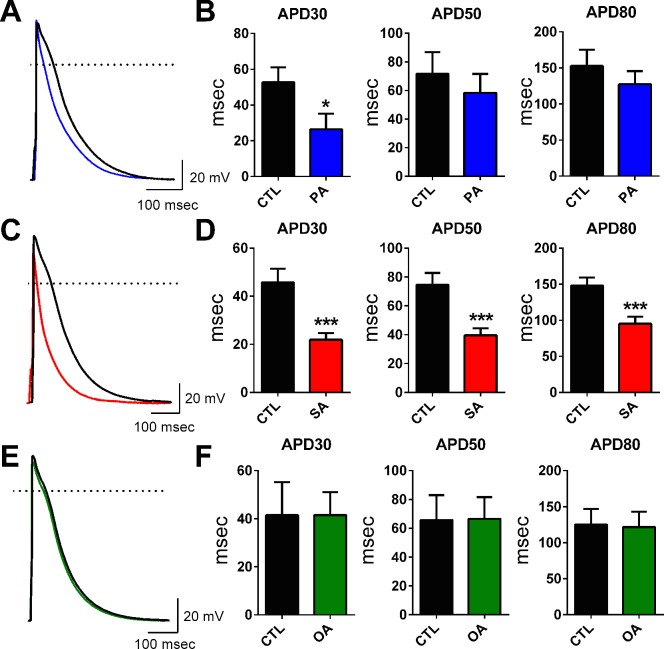
Saturated free fatty acids, but not a mono-unsaturated fatty acid, shorten action potential duration in atrial cells.Panels A, C, E; Atrial myocyte action potential recordings in control solution (CTL, black) and following incubation in solutions containing 10 μm palmitic acid (PA, blue), stearic acid (SA, red) or oleic acid (OA, green). Average APD30, 50, & 80 measurements in CTL and following incubation in PA (Panel B, n = 9, 12; *p<0.05), SA (Panel D, n = 22, 24; ***p<0.001) and OA (Panel F, n = 6, 5). CTL solution in this and subsequent Figs, represent vehicle control, see Methods section. Scale bars: 100 msec and 20 mV.